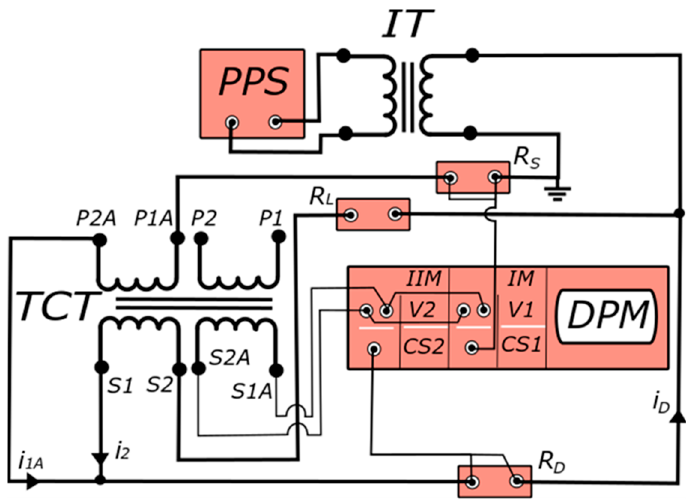
Figure 3. Measuring circuit used for construction of the vectorial diagram.